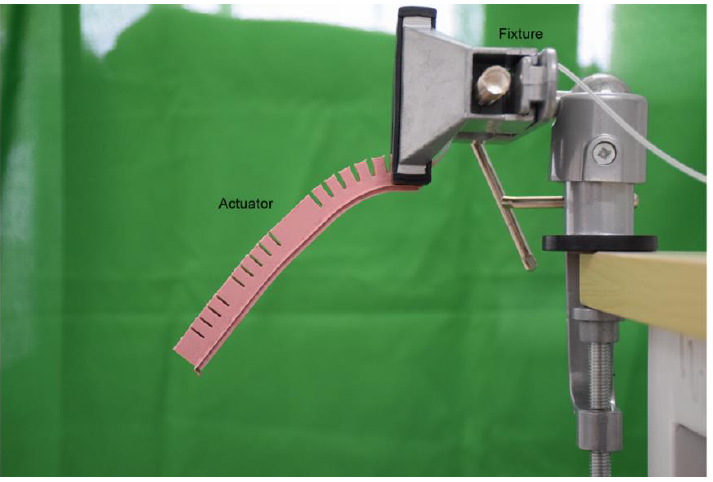
Figure 10. The experimental scenario.